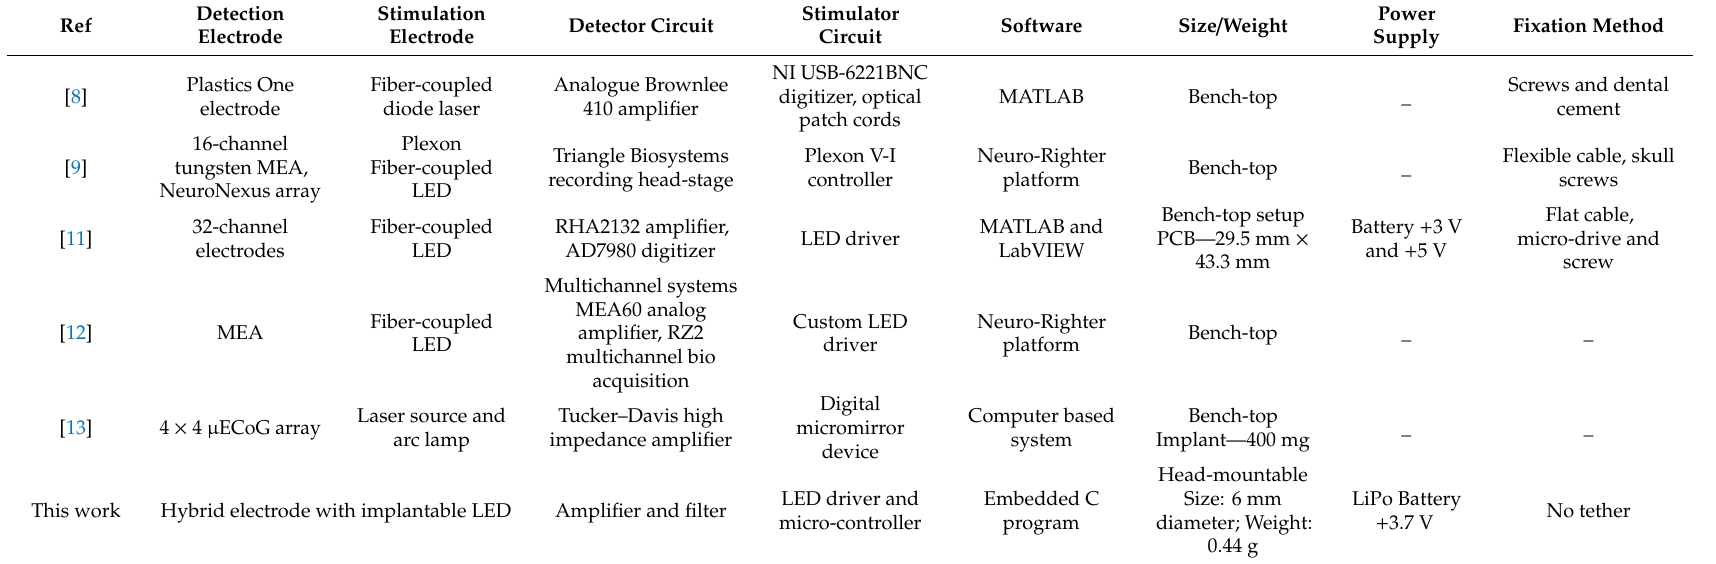
Table 1. Comparison of the developed CLOS device against existing